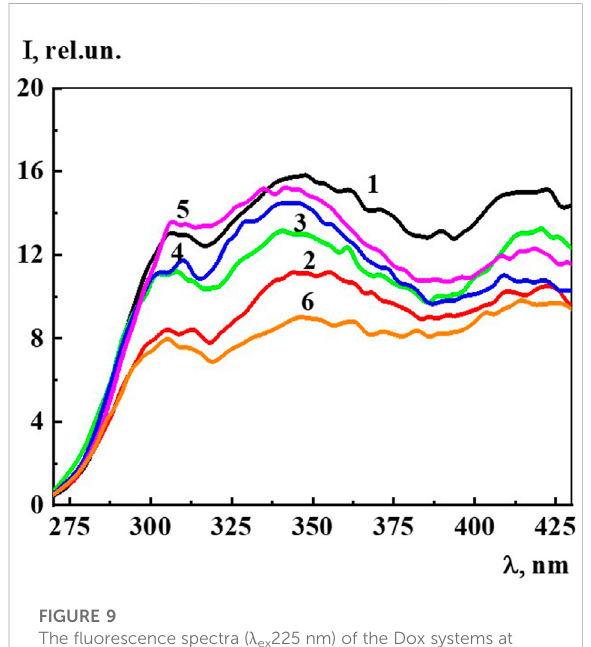
FIGURE 9 The fl uorescence spectra ( λ ex 225 nm) of the Dox systems at